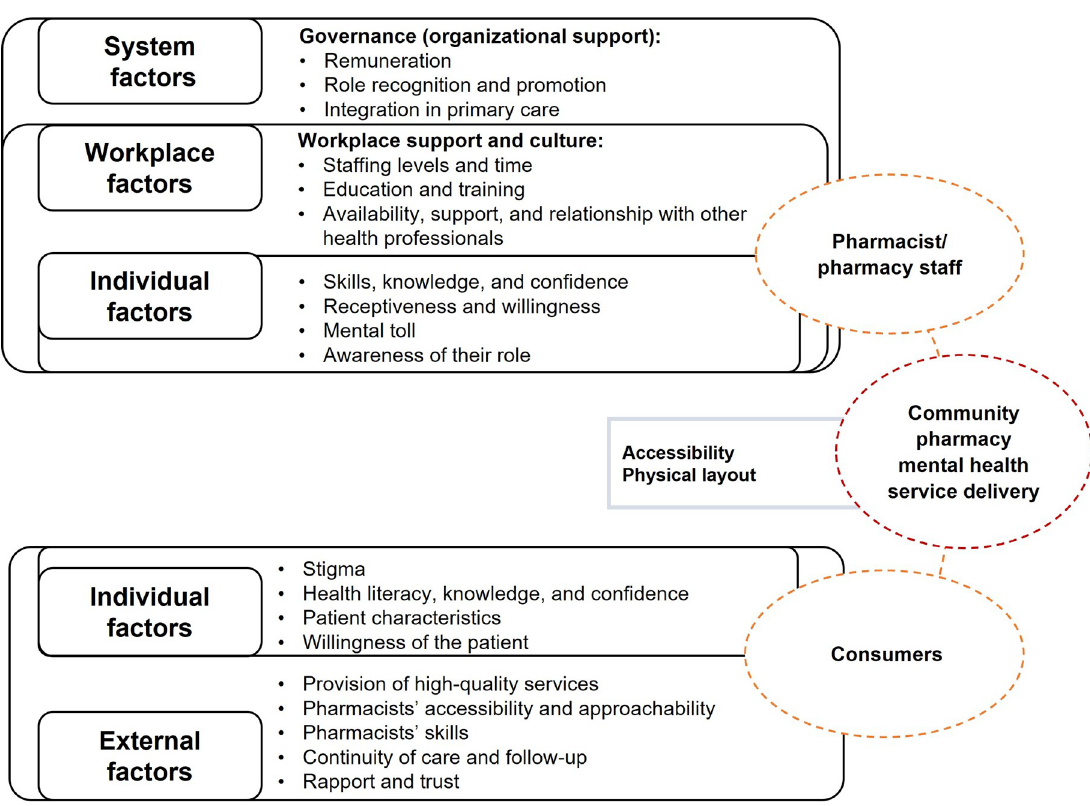
Fig 3. Framework for pharmacists, pharmacy staff and consumers’ empowerment in mental